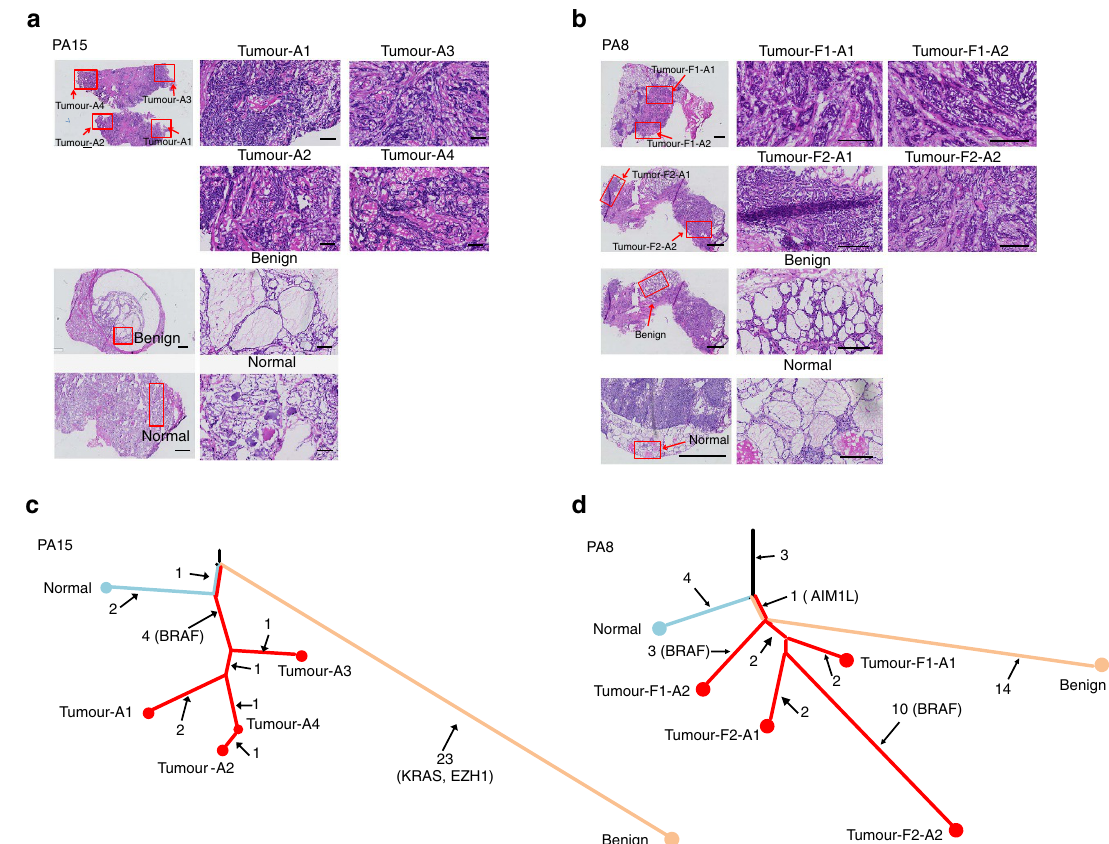
Figure 5 | Phylogenetic analysis of individual patients demonstrates independent sample origins. Two representative trees show examples of unrelated (PA15) and distantly related (PA8). ( a , b ) H&E staining of sampled thyroid tissues from patient PA15 ( a ) and PA8 ( b ). The left panel provides a histological view of the entire sample (bar, 1cm) with the sampling region indicated by red box. Enlarged views of the sampled regions are shown in the right panels (bar, 200 m m). ( c , d ) Phylogenetic trees based on mutation observed in PTC tumour, benign nodule(s) and normal tissue. The length of each line is proportional to the quantity of somatic mutations. The number of mutated genes is indicated near the line, and genes with key non-synonymous mutations were RNA sequencing . Total RNA was prepared with QIAzol Lysis Reagent and RNeasy MinElute Cleanup Kit (Qiagen, Hilden, Germany). On the basis of the resulting RNA integrity analysis, samples were divided into two sets for tran- scriptome sequencing. Set 2 (RNA integrity number, RIN 4 7.0) included tissue samples from two TB (PA7 and PA12) and two SB patients (PB5 and PB6). The cDNA library construction for these samples was performed using Illumina TruSeq RNA Sample Preparation Kit. Set 1 (RIN 4 6.0) included four TB patients (PA3– PA6) and four SB patients (PB1–PB4) from the WES cohort, and an independent set PA21. The cDNA library was constructed using Ribo-Zero Gold Kit (Illumina, San Diago, CA). A total of 40 samples (Supplementary Data 6) were sequenced using Illumina HiSeq2500 platform, and 100-bp paired-end reads were generated. RNA-Seq data analysis . The RNA-Seq reads were mapped to the human genome (hg19) and transcriptome (gencode version 19) using the software RNA STAR (version 2.4), which can align reads across splice junctions with or without gene annotations. Gene expression was calculated as FPKM with R package edgeR (version 3.8.5). Genes with FPKM values less than 1 in all samples were removed. Hierarchical clustering analyses were performed using log2 transformation of the FPKM matrix (the FPKM value were adjusted by 0.1 to avoid a logarithm of 0), and 1-Pearson correlation coefficient was used as distances. We used an R package DEseq2 (version 1.6.1) to compare expression levels between sample pairs. Paired tests were performed, where different patients were treated as biological replicates. We used fold change 4 1.5 and FDR o 0.01 as thresholds to define DEGs. The thyroid differentiation and signalling features were evaluated by three groups of genes (16 genes for thyroid differential, 52 genes for ERK activity and 71 for characters of BRAF V600E /RAS mutation) as previously reported 3,8 . Briefly, to get TDS score, the median of FPKM values of the 16 genes for thyroid differential (log2-normalized) were calculated, minus the corresponding median and summed across the 16 genes for each sample. The Z-score of FPKM values for the 52 ERK-related genes was used as ERK-activity score. The expression levels of 71 BRAF V600E /RAS related genes in each sample in our cohort were used